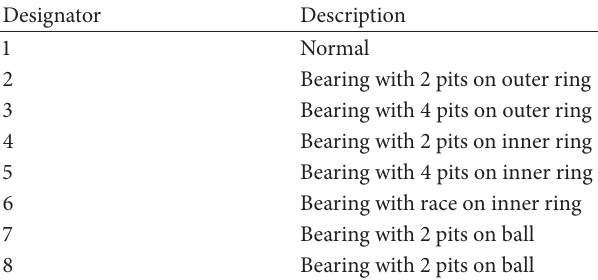
Table 4: Nomenclature of bears